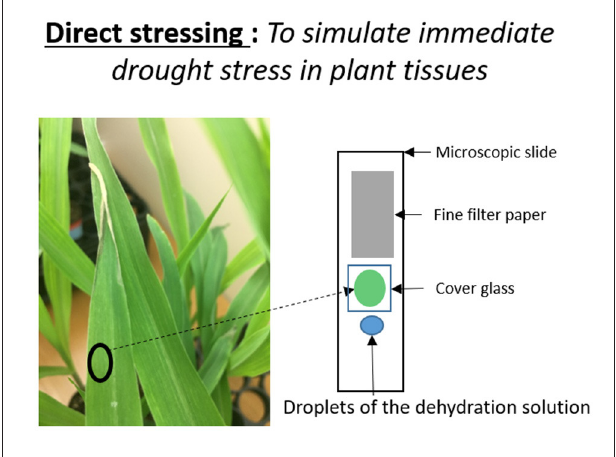
FIGURE 1 | Illustration of the immediate osmotic stress